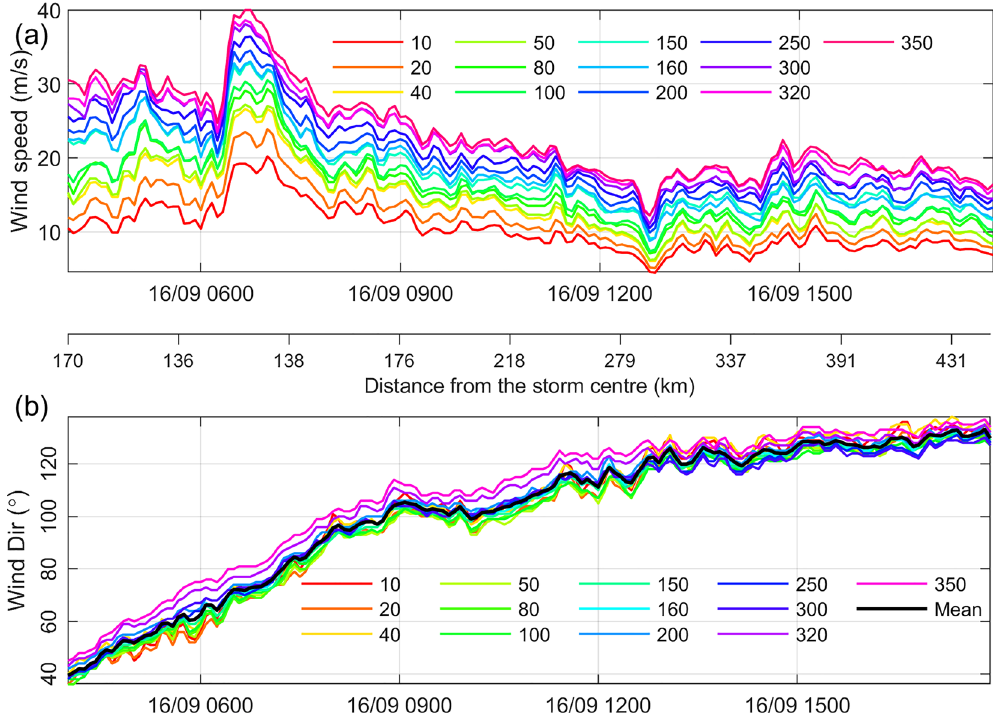
Figure 5. Observations obtained at 13 vertical levels of the Shenzhen Meteorological Tower from 04:00 to 18:00 on 16 September 2018: ( a ) 10-min average wind speed and ( b ) 10-min average wind direction. In panel ( b ), the thick black line shows the mean wind direction averaged over the 13 levels. The axis between the two panels shows the relative distance of SMT from the storm centre (km) according to the real-time track data from China Meteorology